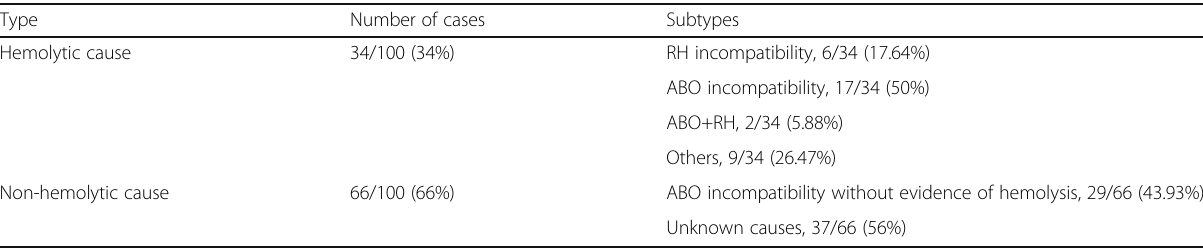
Table 4 Types of jaundice among the studied neonates